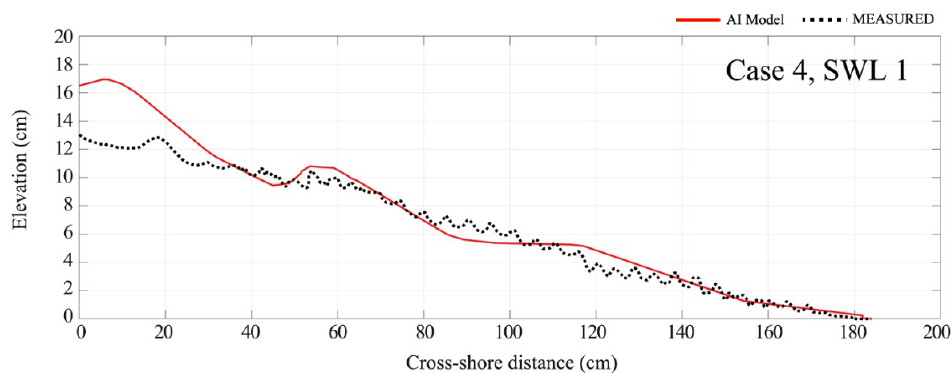
Figure 19. Case 3 SWL 2 comparison of the ANN prediction and measured from the physical test.